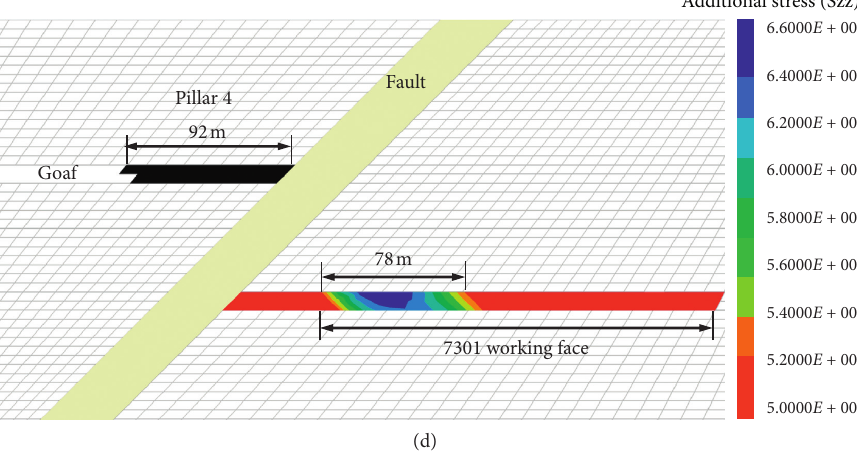
Figure 6: The width of pillars in the profile and corresponding distribution range of additional stress. (a) The profile along the middle of pillar 1. (b) The profile along the middle of pillar 2. (c) The profile along the middle of pillar 3. (d) The profile along the middle of pillar 4.